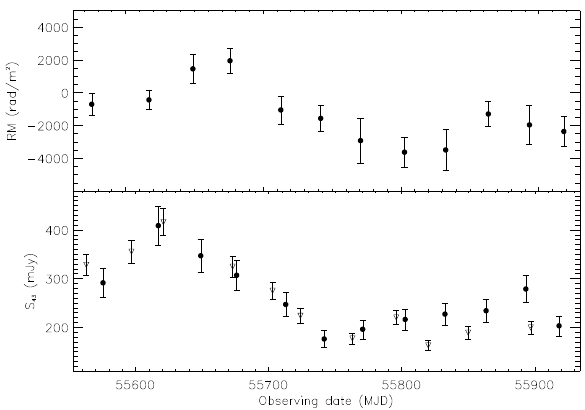
Figure 1. Upper frame: rotation measure (RM) time evolution in the core region of Mrk421 (see Section 2 for details). Lower frame: time evolution of the 43GHz total intensity emission in the core region of Mrk421. This image is adapted from Figures 2 and 5 presented in L14. Filled circle symbols represent data from L14; the empty triangle symbols in the lower frame are data provided by the VLBA-BU-BLAZAR monitoring program 1